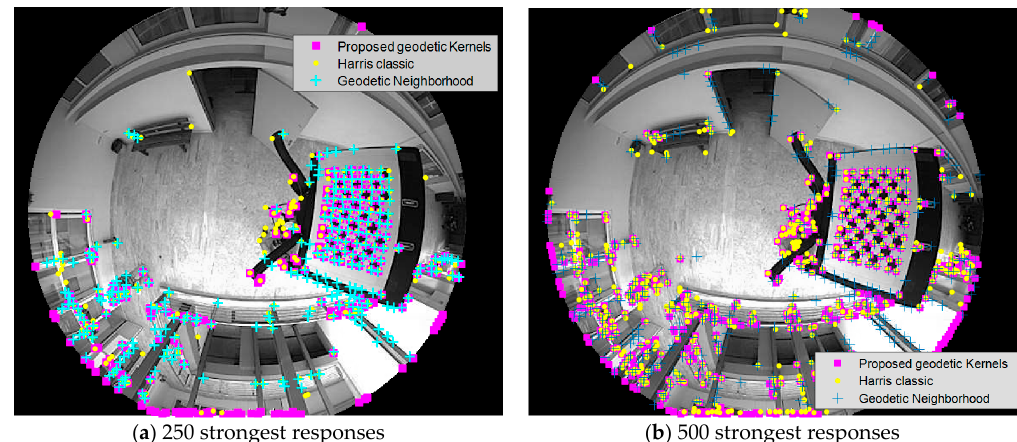
Figure 16. Corner pixels detected by the proposed geodetically corrected Harris detector (shown in yellow) by the classic detector (magenta) and by the geodetic Harris in [22] (blue crosses), with 5 × 5 kernel size, considering: ( a ) the 250 strongest corner responses and ( b ) the 500 strongest responses.